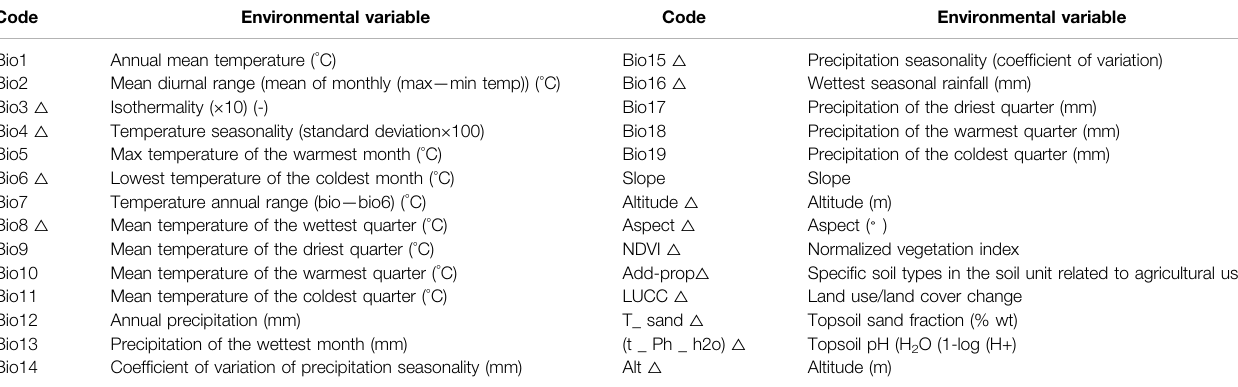
TABLE 1 | Environmental predictors selected in the model building after correlation